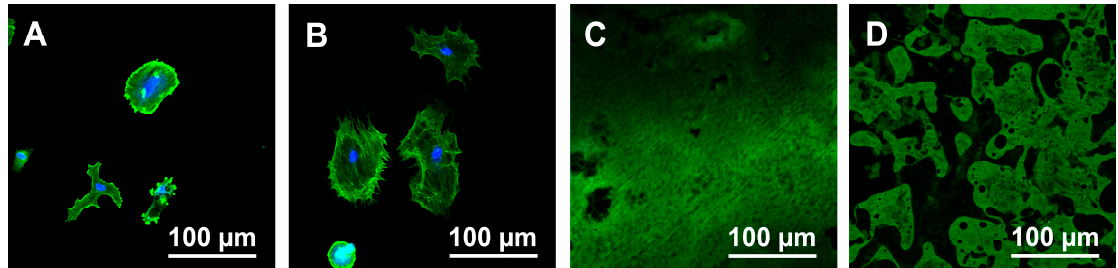
Figure 5. Morphological analysis of rat bone marrow mesenchymal stem cells (rBMMSCs) attached to sample disks. Tallow-Ti ( A ), Finevo-Ti ( B ), Plasma-Ti ( C ), and UV-Ti ( D ) disks were incubated with rBMMSCs for 24 h, stained with phalloidin (F-actin) and DAPI (nuclei), and visualized by fluorescence microscopy.